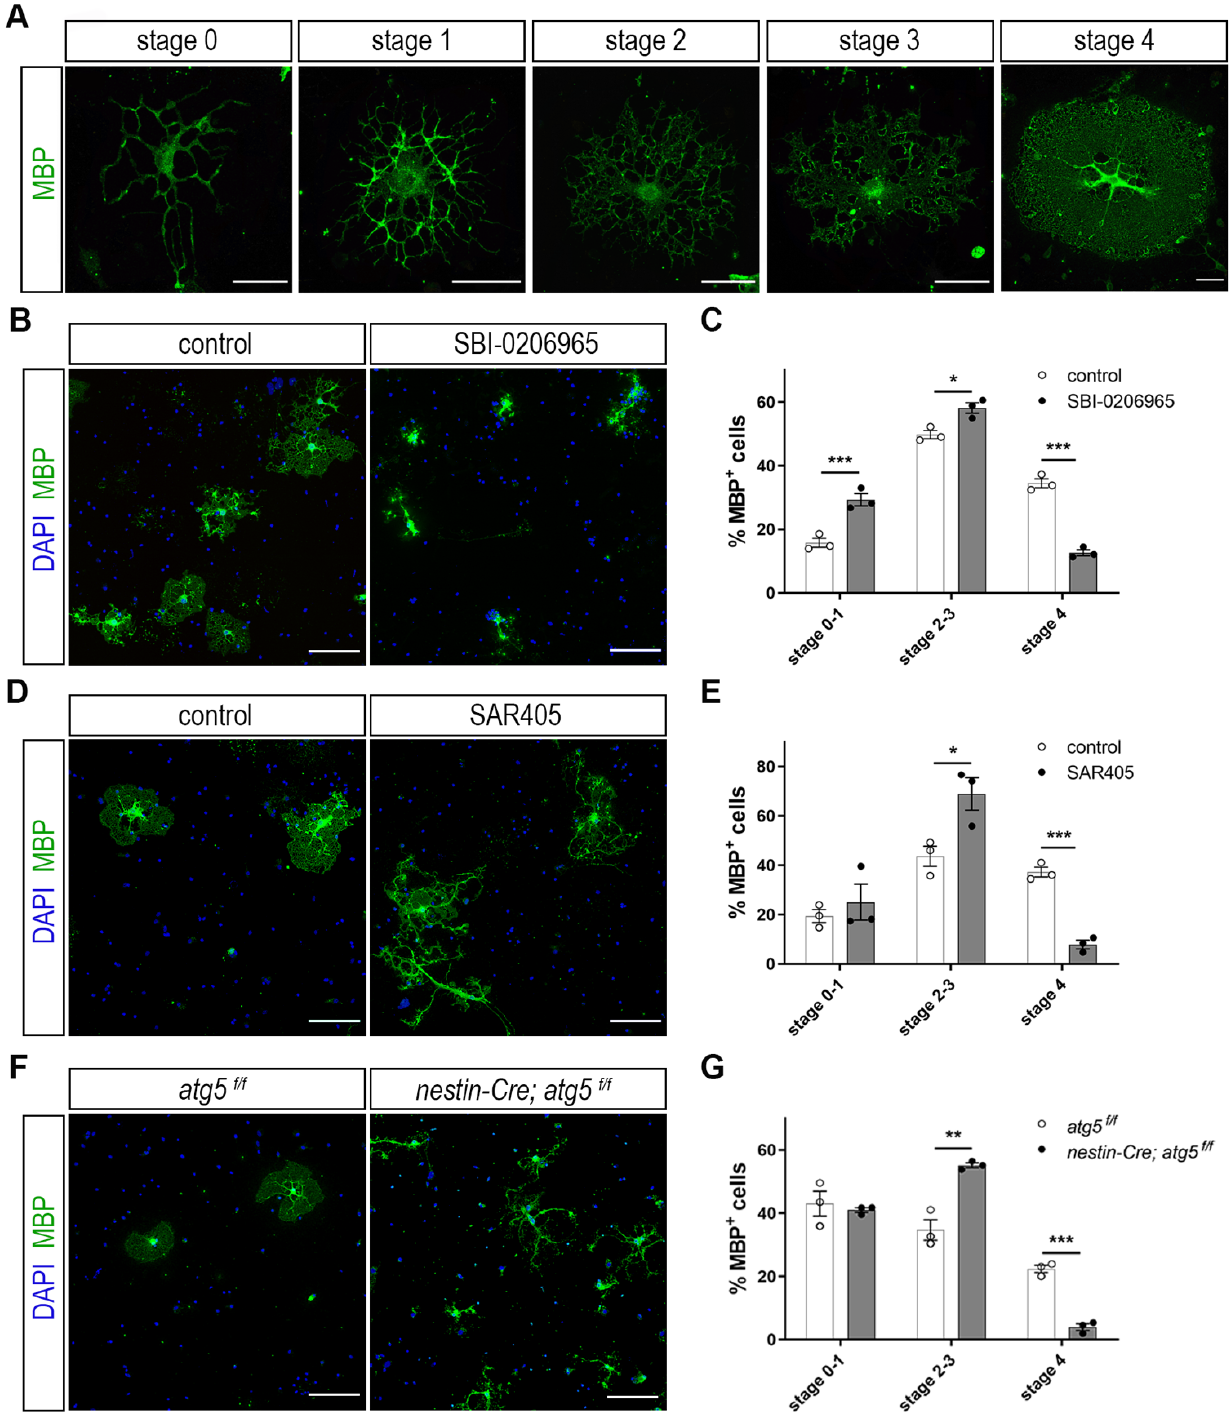
FIGURE 1: Pharmacological and genetic inhibition of autophagy results in maturation defects in oligodendrocytes. (A) Representative ex- amples of mature DIV5 MBP-expressing OLs (MBP in green) that can be subdivided in five maturation stages. Scale bars: 30 μm. (B) Repre- sentative confocal images of DIV5 primary oligodendrocytes (OLs), immunolabeled for MBP (green) and DAPI (blue). Cells were either vehicle treated (control), or treated for 5 days with 1μM SBI-0206965. Scale bars: 100 μm. (C) Quantification of the percentage of the MBP+ OLs found in the stages described in the text. (D) Representative confocal images of cultured DIV5 primary oligodendrocytes (OLs), immuno- labeled for MBP (green) and DAPI (blue). Cells were either vehicle treated (control), or treated for 5 days with 1μM SAR405. Scale bars: 100 μm. (E) Quantification of the percentage of the MBP+ OLs found in the categories described in the text. (F) Representative confocal images of DIV2 primary control ( atg5 f/f ) and cKO ( nestin-Cre; atg5 f/f ) OLs immunolabeled for MBP (green) and DAPI (blue). Scale bars: 100 μm. (G) Quantification of the percentage of the MBP+ OLs found in the categories described in the text. Data information: Data are shown as mean ± SEM. N=3 independent experiments per condition. An average of 170-200 cells per treatment per experiment were analyzed. For the quantifi- cation of OL complexity, Student’s t-test was used to determine statistical significance between control and treated/cKO cells of each stage. *p < 0.05, **p ≤ 0.01, ***p ≤ OPEN ACCESS | www.cell-stress.com